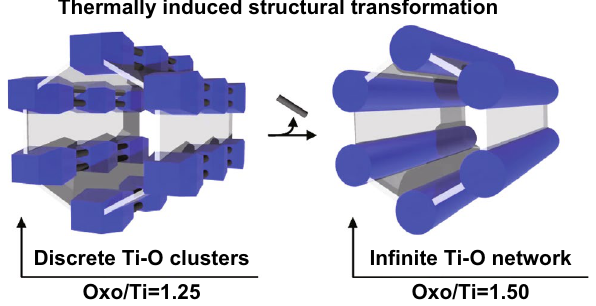
Fig. 4 Thermally induced phase transformation of MIL-177. Reprinted with permission from Ref. [17]. Copyright 2018, Springer